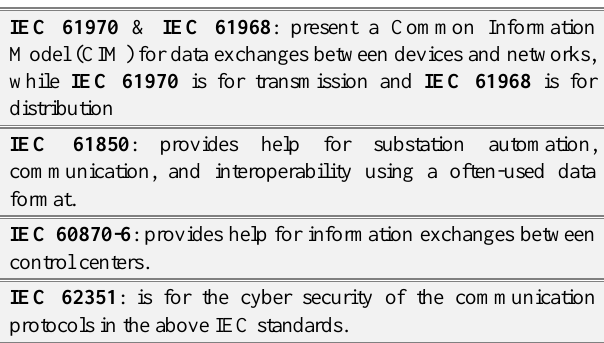
Table 5: IEC Standards Recommended for